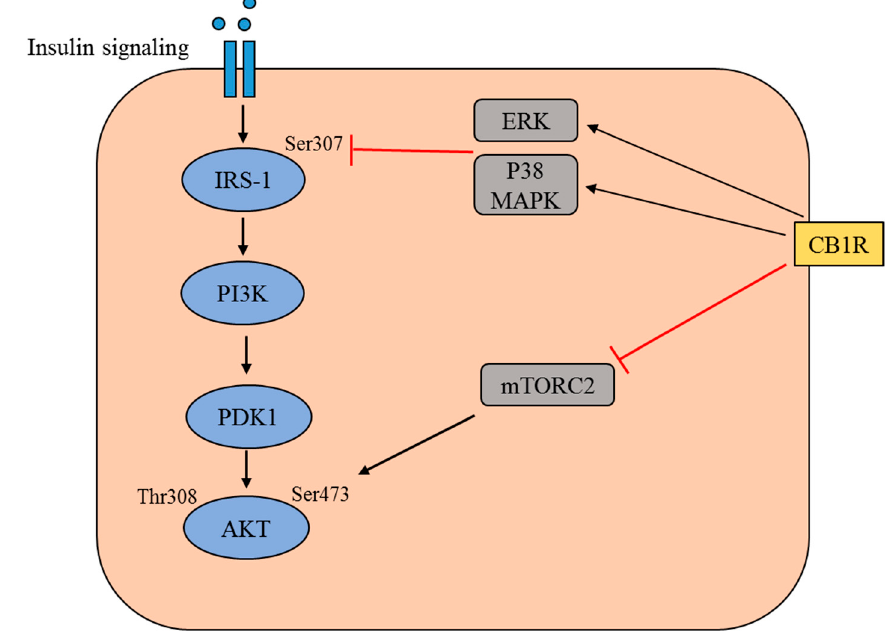
Figure 1. Schematic representation of the insulin signaling pathway and the modulation of this pathway by cannabinoid receptor type 1 (CB1R). The binding of insulin to the insulin receptor triggers a signaling cascade, which involves tyrosine phosphorylation of insulin receptor substrate 1 (IRS1) and the activation of phosphatidylinositol 3-kinase (PI3K). This leads to an increase in the level of phosphatidylinositol-3,4,5-trisphosphate, which recruits Akt to the plasma membrane alongside phosphatidylinositol-dependent kinase 1 (PDK1). In this cascade, Akt is phosphorylated at Thr308 by PDK1 and at Ser473 by mammalian target of rapamycin complex 2 (mTORC2). The activated CB1R mediates the activation of extracellular regulated kinase (ERK) and p38 mitogen-activated protein kinase (MAPK), which subsequently inhibits the Ser 307 phosphorylation of IRS1. Activated CB1R is also believed to inhibit the activation of mTORC2, thereby preventing the Ser473 phosphorylation of Akt.